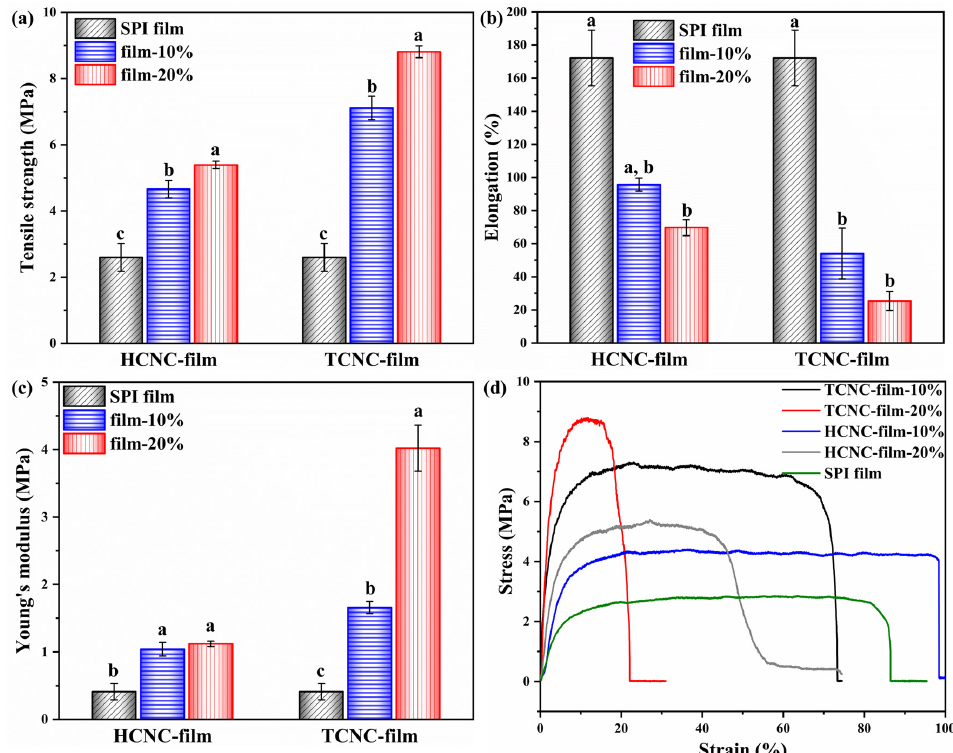
Figure 7. Tensile strength ( a ), elongation at break ( b ), Young’s modulus ( c ), and stress–strain curves ( d ) of SPI and SPI/CNC films. Different letters on the tops of the columns indicate significant difference ( p < 0.05) in terms of CNC content.